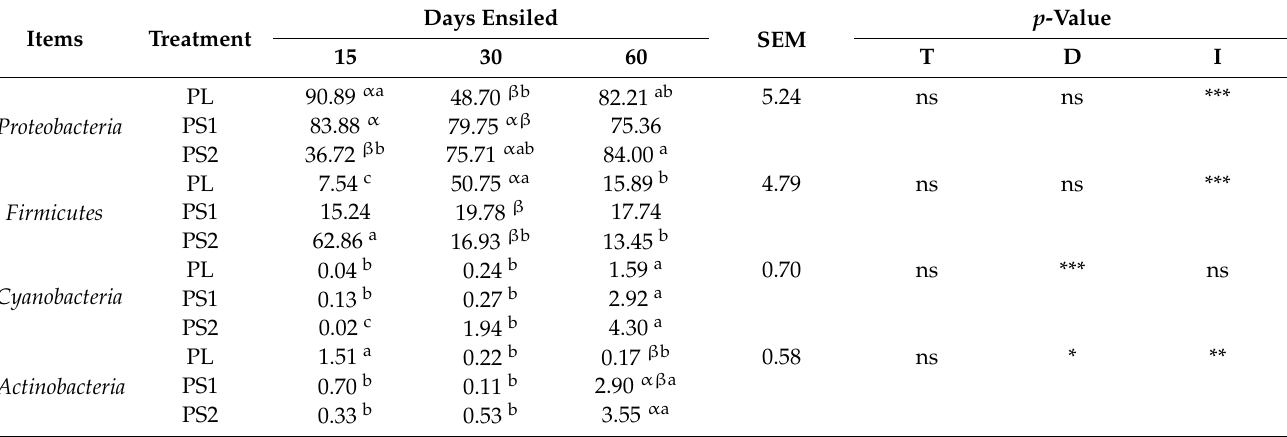
Table 5. Relative abundance of the major phyla (%) present in silage